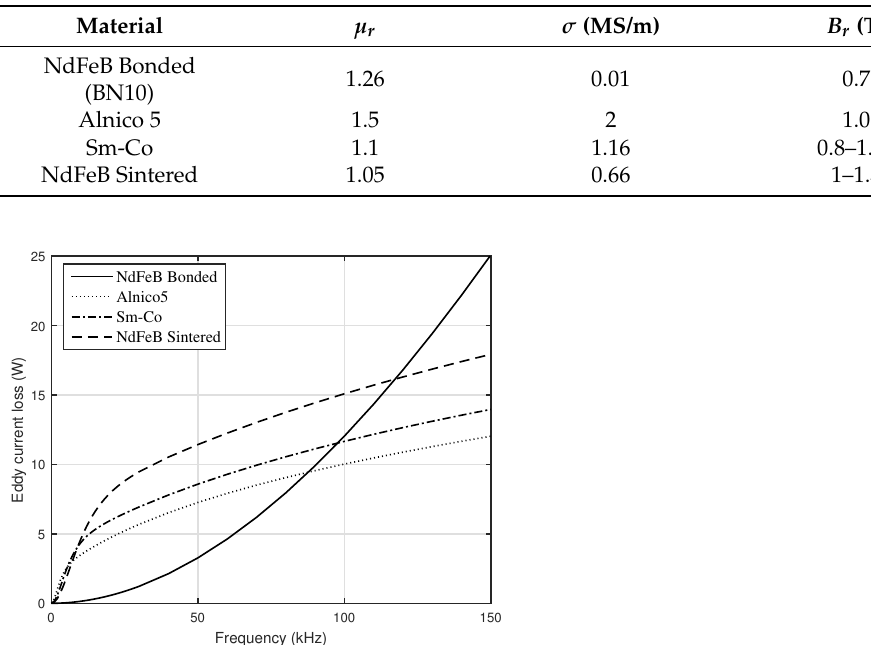
Table 1. Common magnet types and their properties [53].